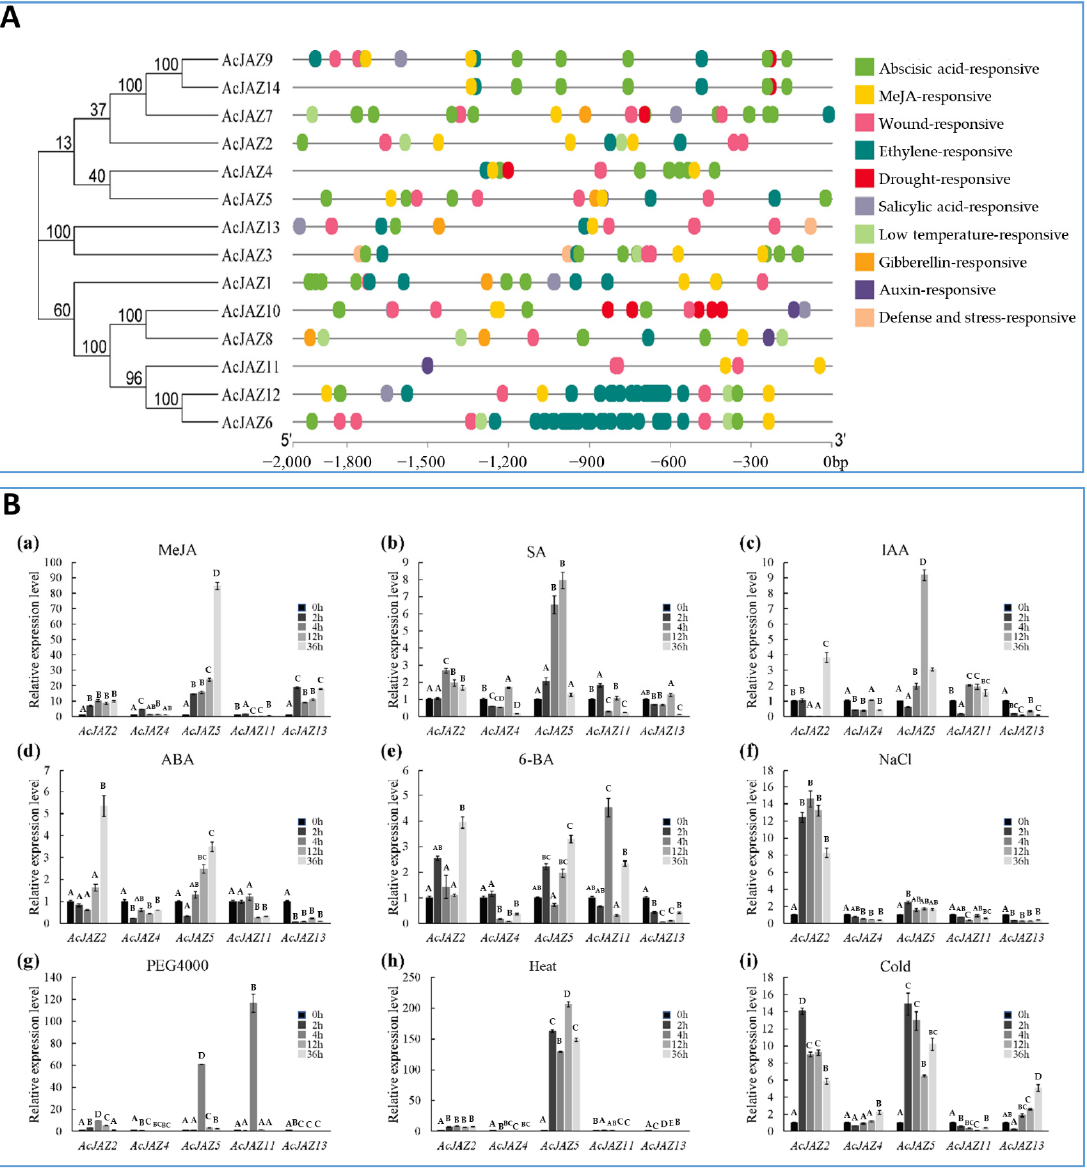
Figure 4. The predicted cis -acting elements in the putative promoter regions of AcJAZs and the expression of AcJAZ genes in response to phytohormone treatments and abiotic stresses. ( A ) The phylogenetic tree of AcJAZs proteins is shown on the left. The abiotic stress-responsive cis -acting elements were predicted by the PlantCARE online tool in the 2000 bp sequences upstream of “ATG” of AcJAZ genes. The types of cis -acting elements were marked by different colors. ( B ) The expression analyses of AcJAZ genes under different treatments. One-month-old pineapple seedlings were treated with MeJA (100 µ M ( a )), SA (100 µ M ( b )), IAA (100 µ M ( c )), ABA (100 µ M ( d )), 6-BA (100 µ M ( e )), NaCl (150 mM ( f )), PEG4000 (15% ( g )), Heat (45 ◦ C ( h )), and Cold (4 ◦ C ( i )). The leaves of the treated seedlings were used for the analysis. AcPP2A gene was used for RT-qPCR normalization. Data in ( B ) were analyzed using one-way ANOVA and post hoc Tukey test, and significant differences are indicated by different letters (upper case) at p <